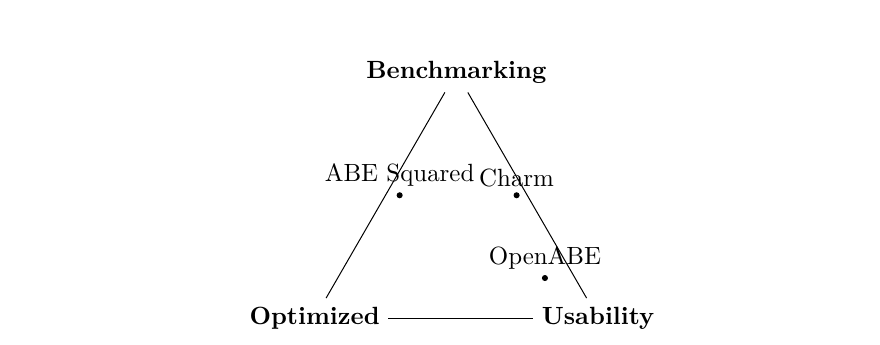
Figure 1: Rough overview of the position of our framework compared to Charm and OpenABE, with respect to the goals: benchmarking, optimization and